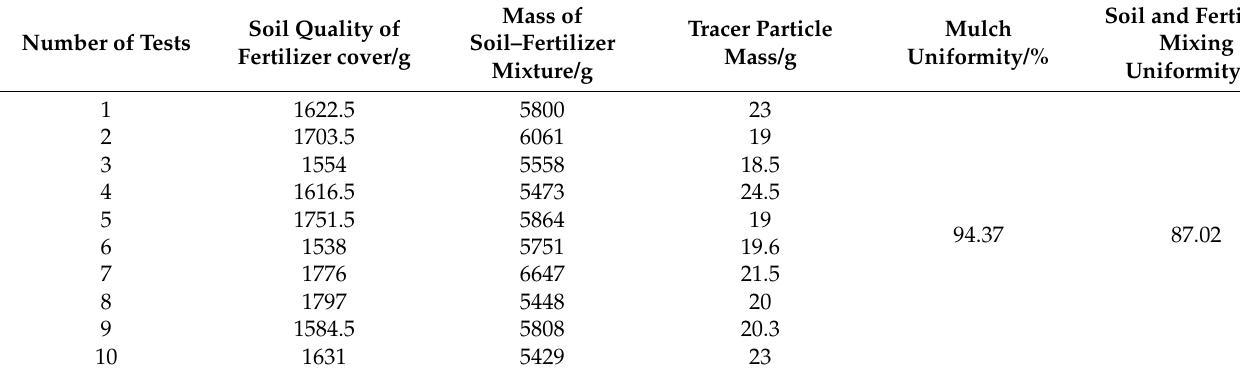
Table 8. Optimization results test